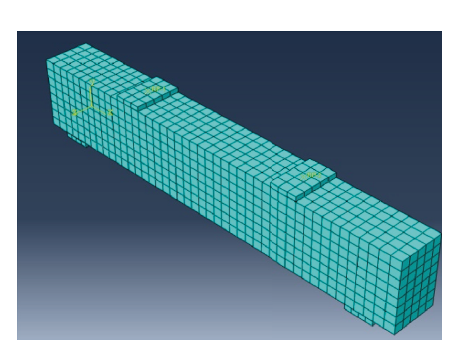
Figure 3: Concrete meshed